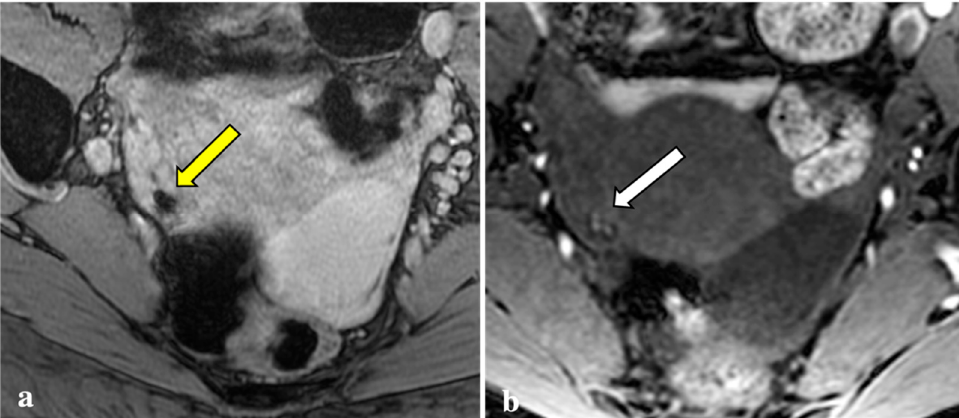
Figure 3. T2*-weighted imaging pitfall. An oval signal void (yellow arrow) localized in the right ovary was detected on T2*-weighted imaging in a 23-year-old patient ( a ). This lesion corresponded to a thick-walled haemorrhagic corpus luteal cyst (white arrow) with an internal high signal on T1W ( b ), consistent with blood content.